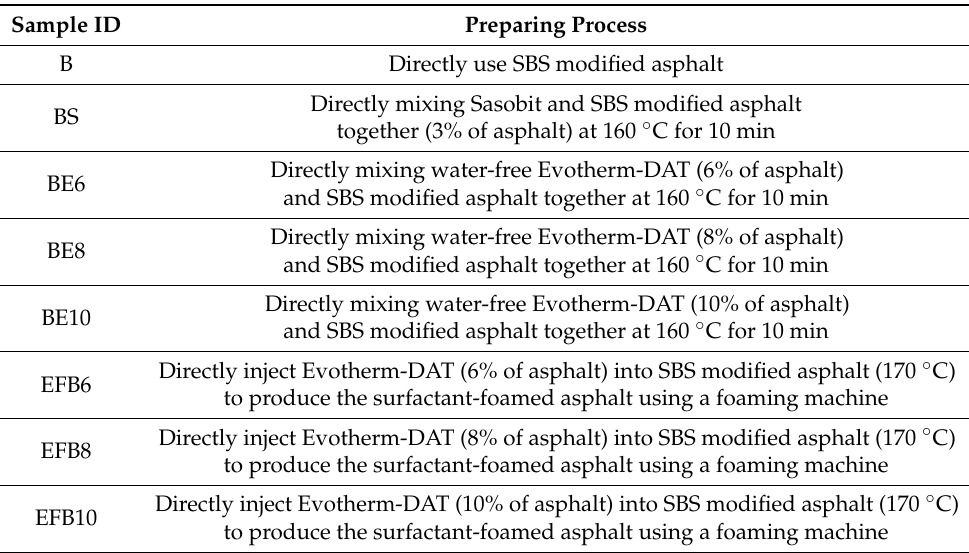
Table 3. Summary of sample IDs and the detailed preparation